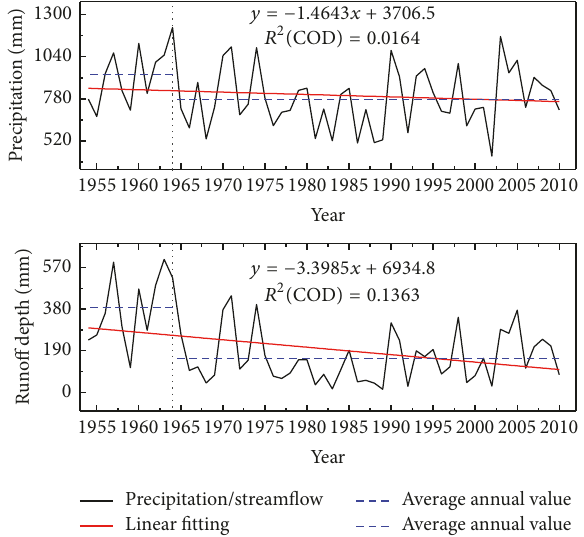
Figure 5: Time series of annual precipitation and runoff depth in Yi River Basin (the thin dashed blue line denotes average value before 1965; the thick dashed blue line denotes average value from 1965 to 2010).